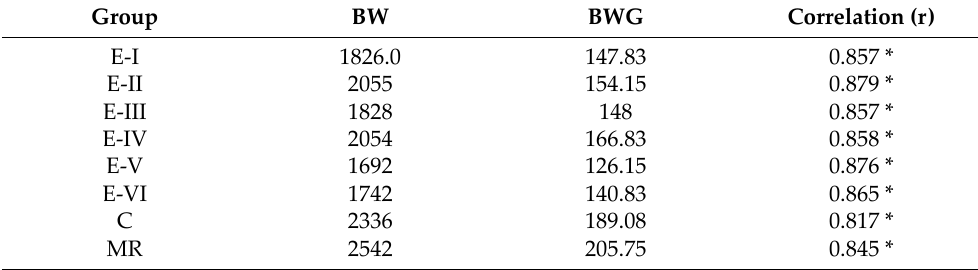
Table 6. Pearson’s correlation coefficient between average BW and average BWG within experimental group. Group